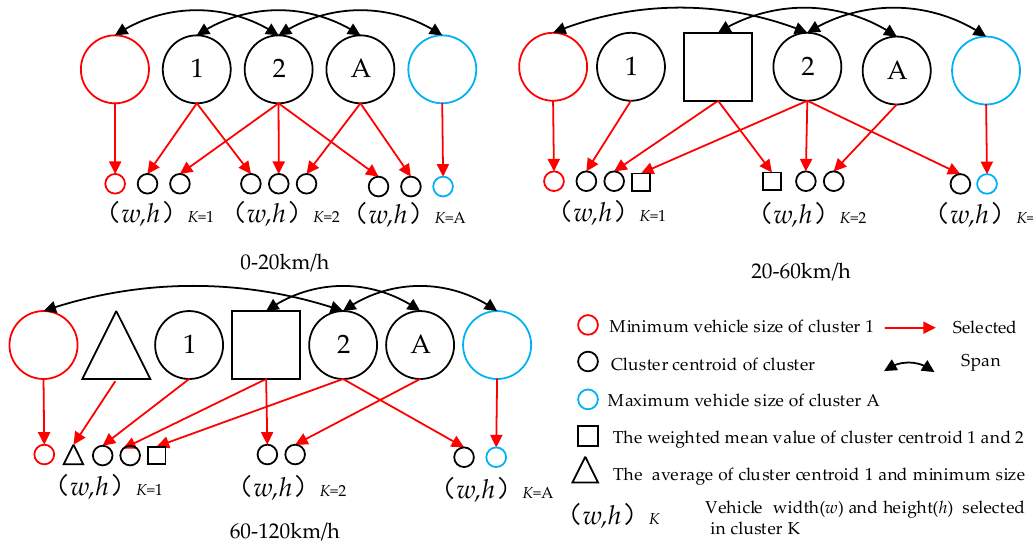
Figure 8. Method of selecting vehicle sizes. Weighted mean value of cluster centroids 1 and 2 is obtained by Equation (7).